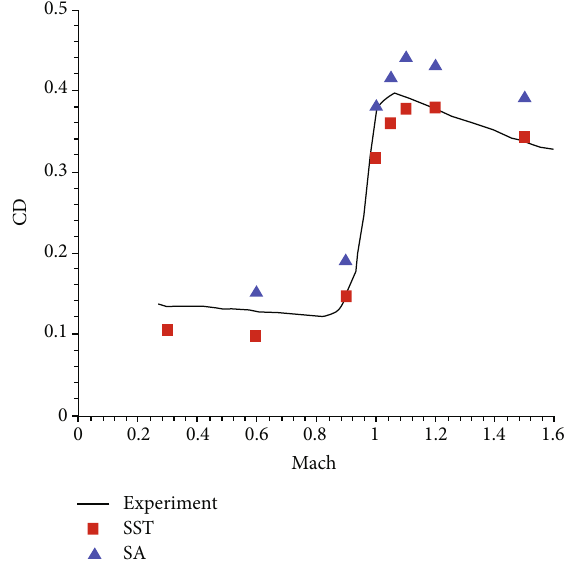
Figure 5: Comparison of drag coe ffi cient, M107